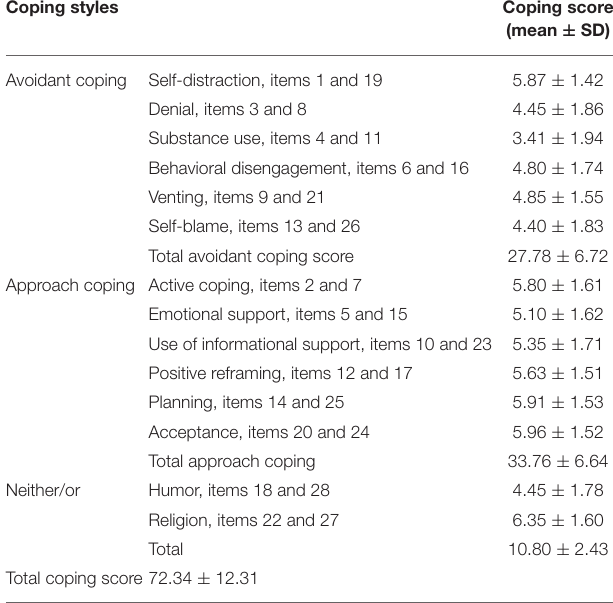
TABLE 5 | Brief coping scale among